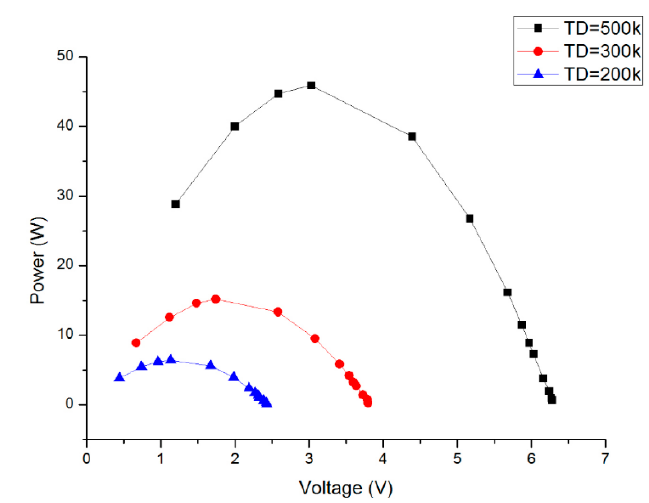
Figure 13. Output power versus voltage.